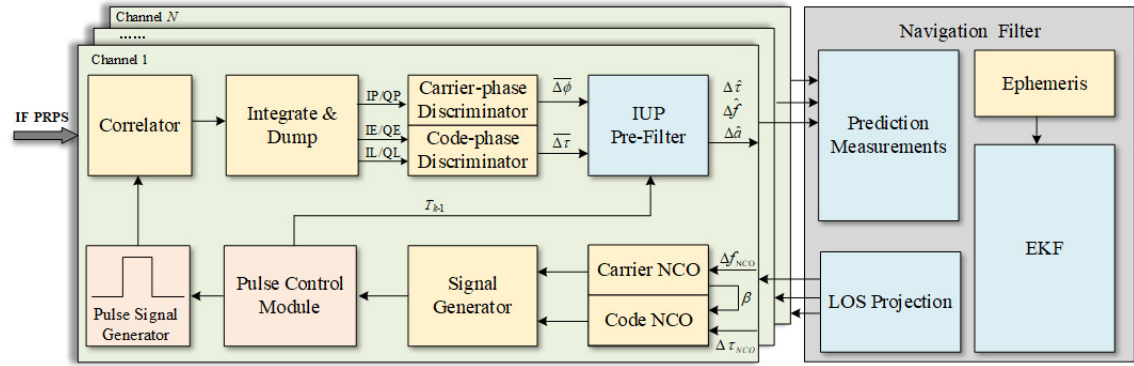
Figure 5. Block diagram of the